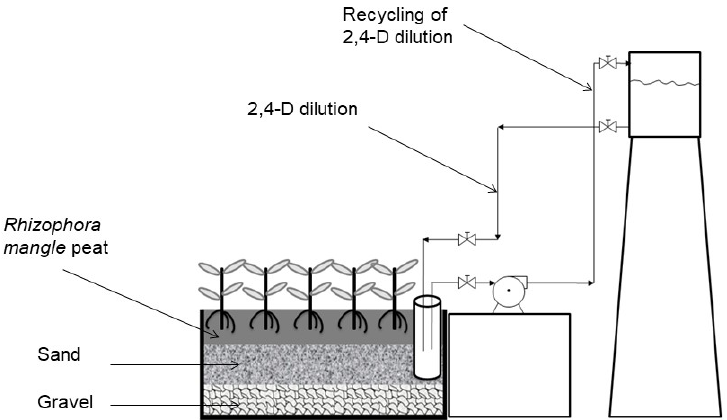
Figure 2. Diagram of the treatment system for exposure to 2,4-D with subsurface recirculation.